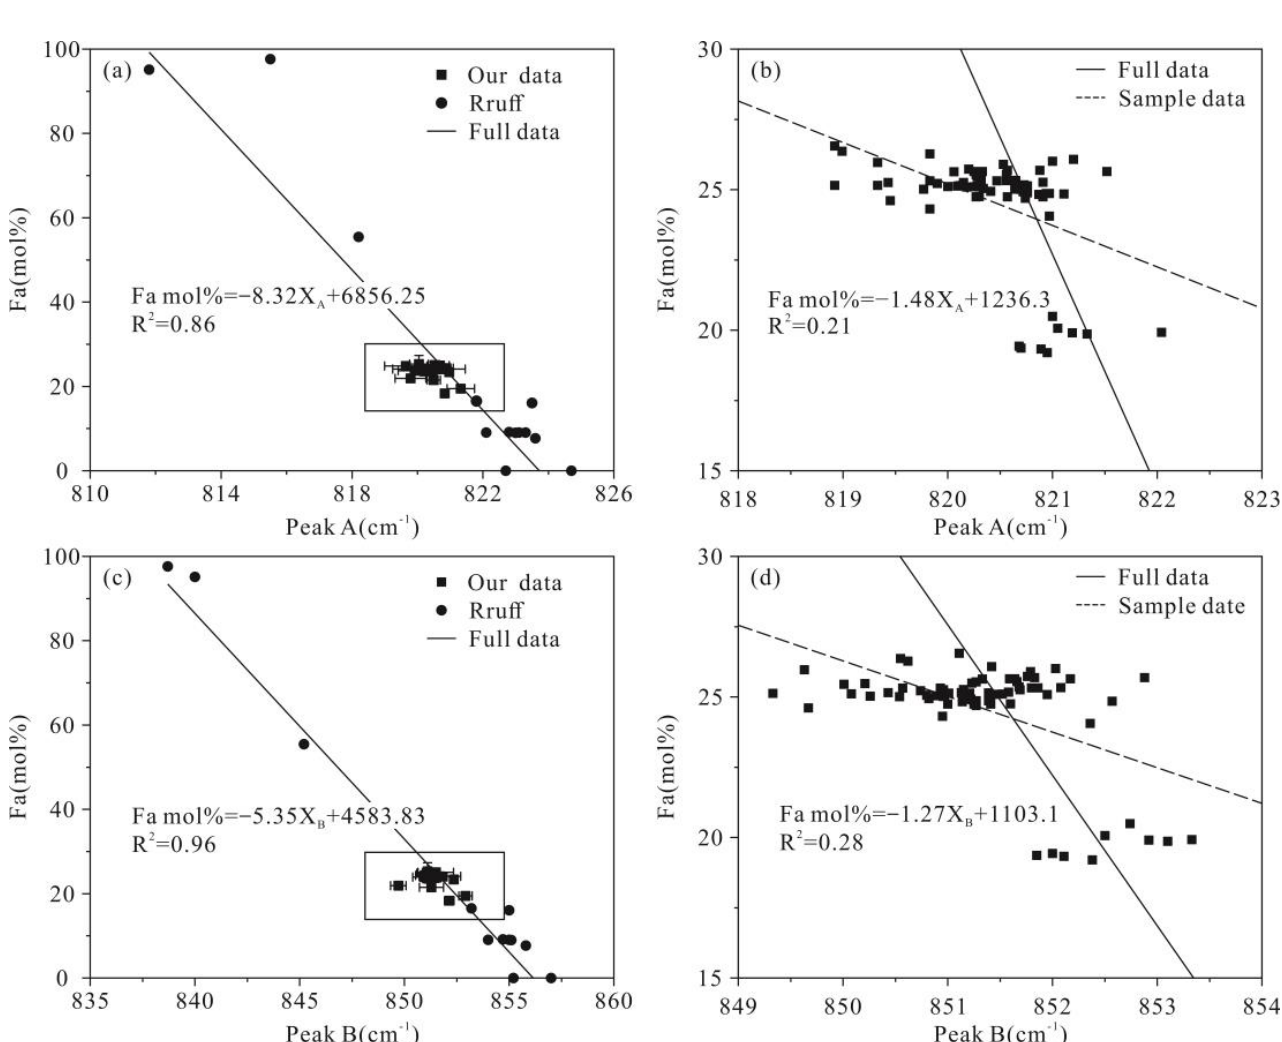
Figure 3. Correlation between the Fa content in olivine and the Raman shift of two selected peaks. ( a , c ) show the results of the fitting from all the data; ( b , d ) show the results of the fitting from our data only. The correlation curve has been calculated using the reference data (circles) and our measurements (filled squares) are plotted for comparison. The error bars represent the standard deviation for 3–5 Raman spectra analyses per chondrite.